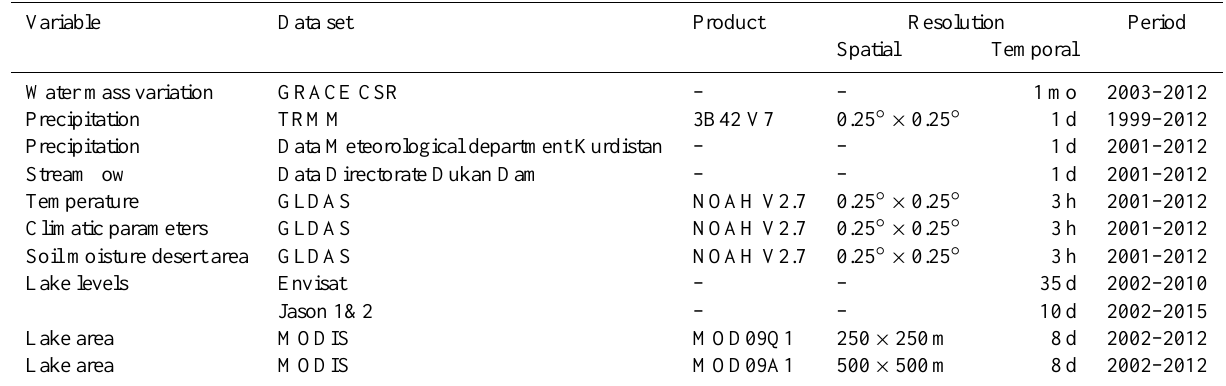
Table 1. Summary of data used in this study Variable Data set